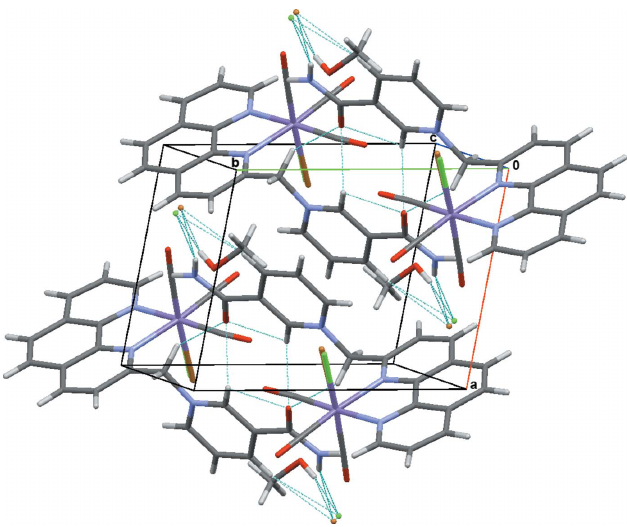
Figure 2 The crystal packing of the title compound with hydrogen bonds shown as dashed lines (for numerical values, see: Table 1).